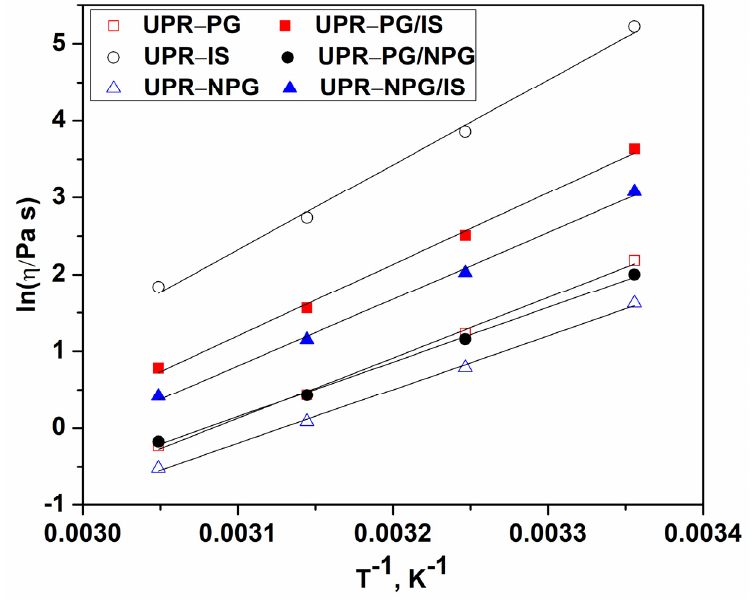
Figure 3. Plots of ln η as a function of 1/T at a constant shear rate (10 s –1 ). Table 2. The UPRs gel content and glass transition temperature obtained by DSC (Tg DSC ) and Table 1. Activation energy of flow (Ea η ) at the constant shear rate (10 s –1 ) of examined UPRs.